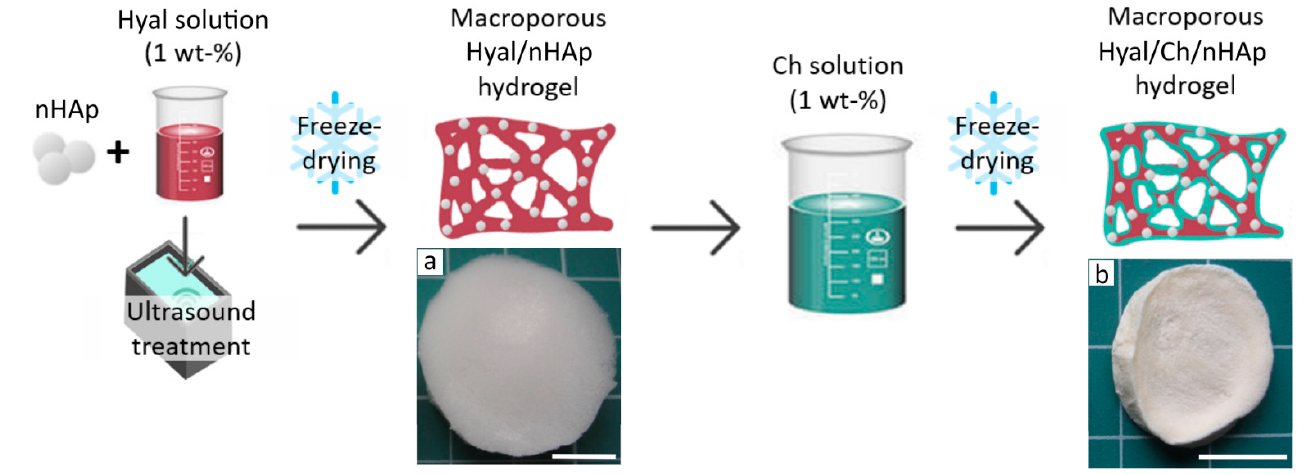
Figure 1. A scheme for fabrication of composite hyaluronic acid/chitosan hydrogels loaded with hydroxyapatite nanoparticles (Hyal/Ch/nHAp). Photographs of the macroporous hydrogel samples prepared from the Hyal solution with hydroxyapatite nanoparticles (10 wt. %) before (a) and after (b) immersion in the chitosan solution. Scale bar is 10 mm.